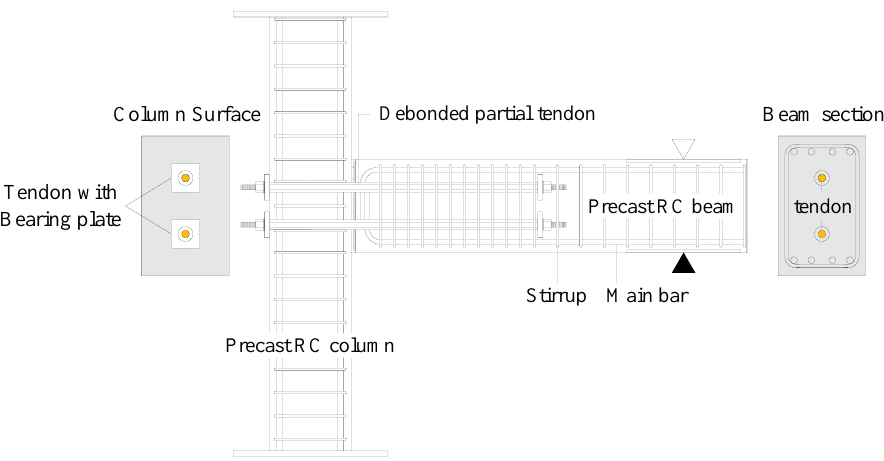
Figure 2. Structural system of prestressed RC frame with debonded partial tendon.